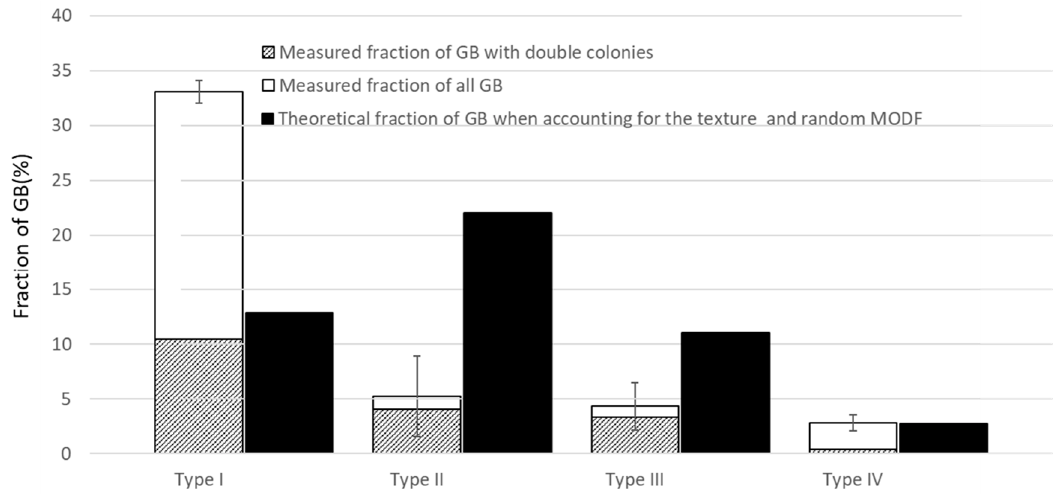
Figure 9. Fraction of special GB in the disk (from data of Figure 2) identified with a tolerance of 10°.